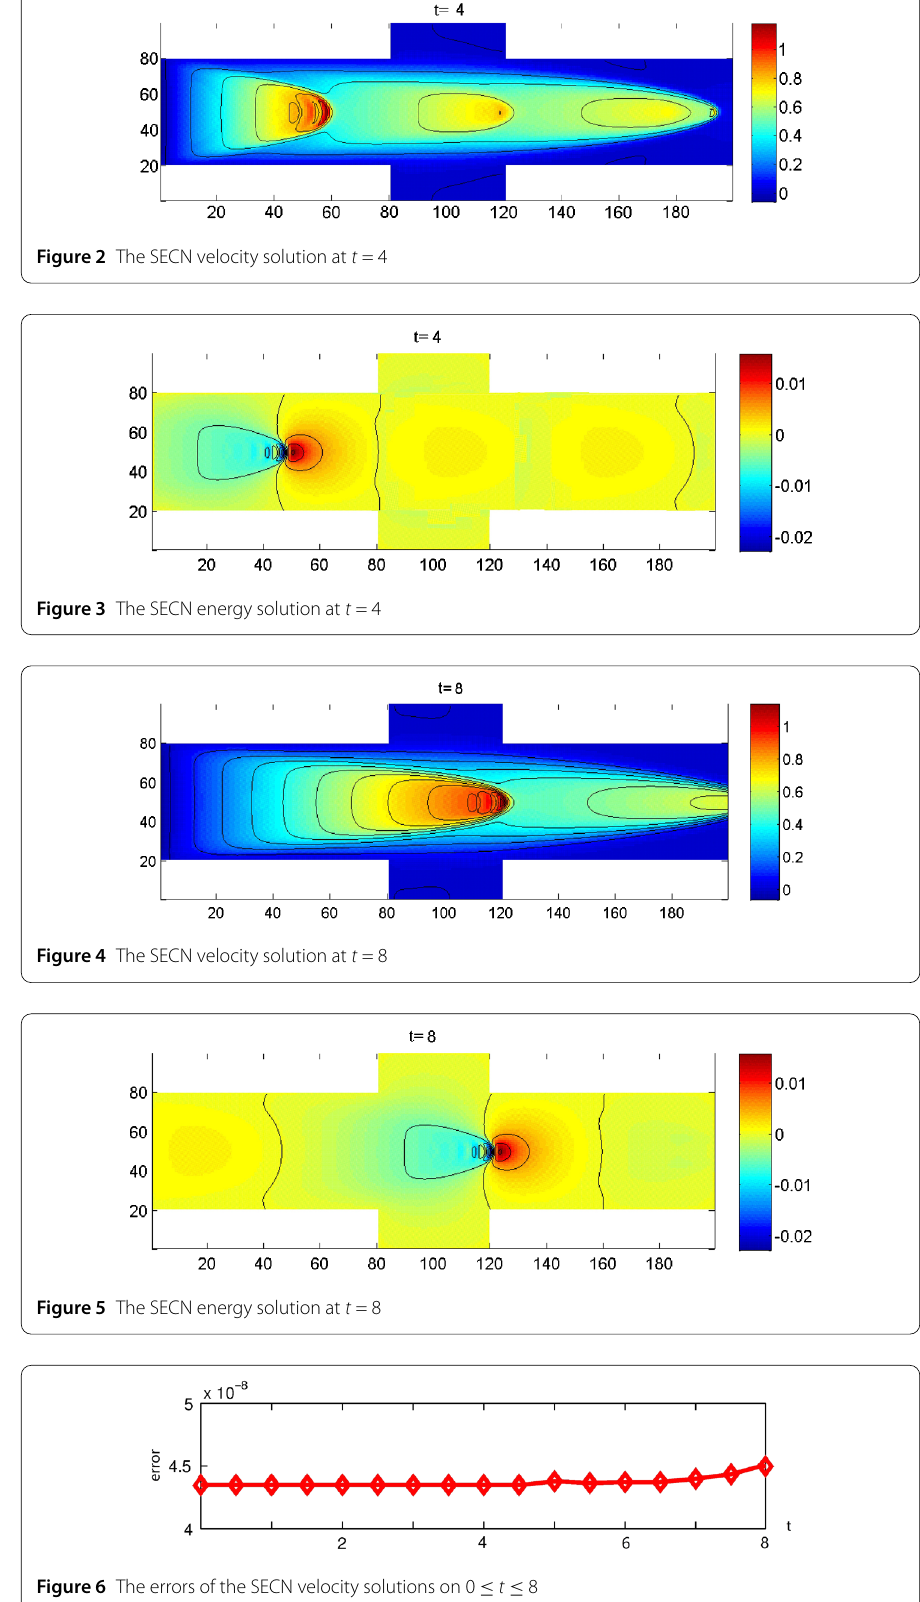
Figure 6 The errors of the SECN velocity solutions on 0 ≤ t ≤